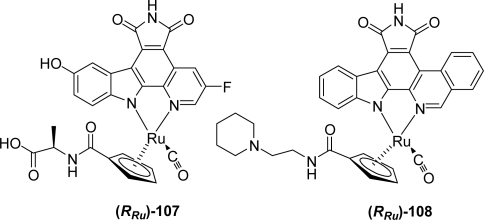
Fluoropyrido- and isoquinolino-pyrrolocarbazole half-sandwich ruthenium complex.